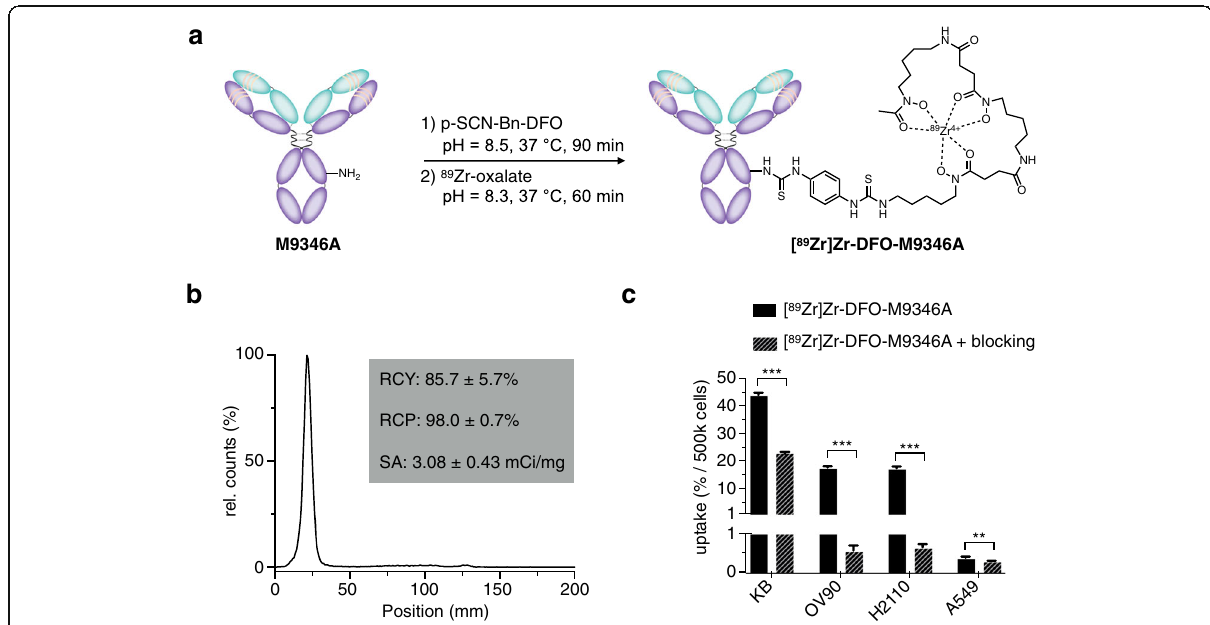
Fig. 2 Synthesis and characterization of [ 89 Zr]Zr-DFO-M9346A. a Conjugation of p -isothiocyanatobenzyl-desferrioxamine (DFO-Bz-NCS) to humanized antibody M9346A in basic aqueous conditions at 37 °C for 90 min and 89 Zr-radiolabeling of DFO-M9346A at 37 °C for 60 min. b After purification of reaction mixture using a PD-10 desalting column, quality control of [ 89 Zr]Zr-DFO-M9346A was performed using radio-instant thin layer chromatography in a solution of EDTA (50 mM). c In vitro uptake studies of either [ 89 Zr]Zr-DFO-M9346A (100 ng) or a mixture of [ 89 Zr]Zr- DFO-M9346A (100 ng) and M9346A (10 μ g) using cancer cell lines KB, OV90, H2110, and A549 with various expression levels of FR α . ** P < 0.01; *** P < 0.001. Error bars represent the